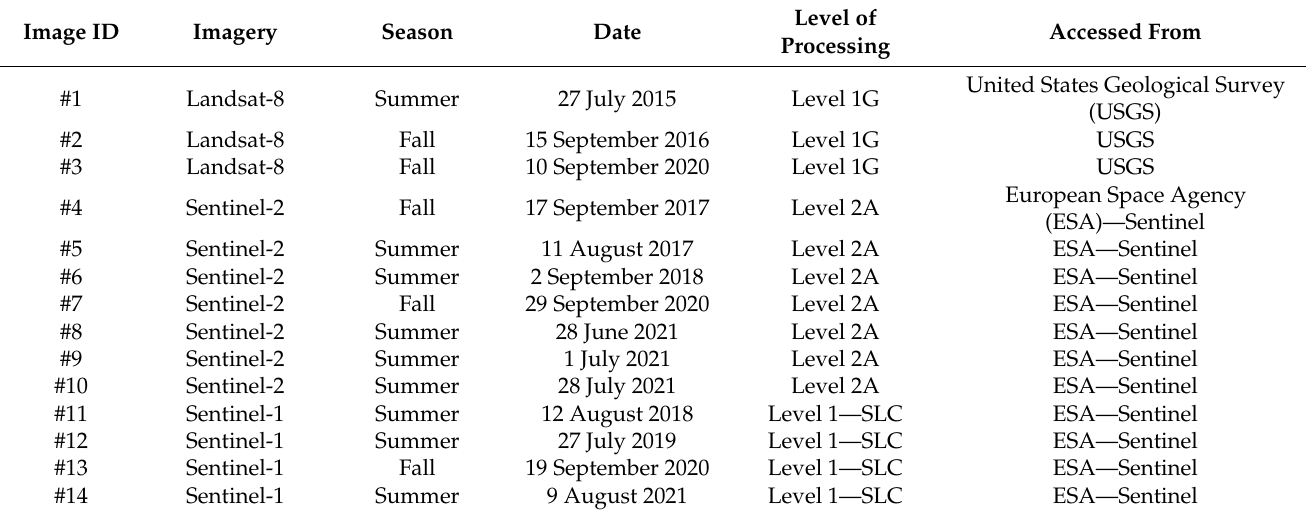
Table 2. Summary of satellite imagery collected for this